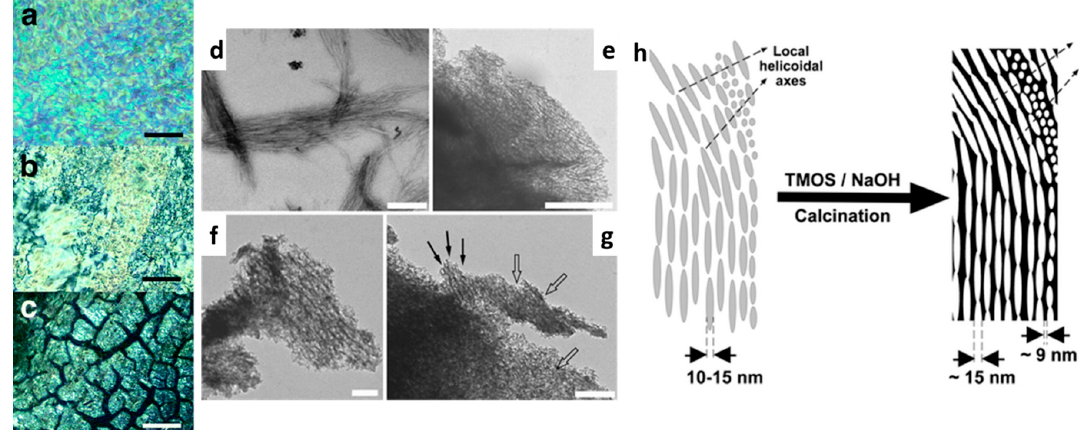
Figure 6. ( a – c ) Polarising optical microscopy images of ( a ) the cellulose nanorod nematic phase (scale bar 10 µm), ( b ) the cellulose–silica composite (scale bar 25 µm) and ( c ) the calcined silica replica (scale bar 50 µm). ( d – g ) TEM images of the unmineralised cellulose template and the silica replica. ( d ) Liquid crystalline nematic domains consisting of 10–15 nm-wide co-aligned cellulose nanorods, scale bar 200 nm; ( e ) the low-magnification image of a crushed mesoporous silica replica showing fingerprint-like patterns with cylindrical pore structure, scale bar 500 nm; ( f ) the fragment of a silica replica showing aligned 13–18 nm diameter cylindrical pores with lengths significantly extended beyond a single cellulose nanorod, scale bar 100 nm; ( g ) the high-magnification image of a silica replica showing the possible in-plane (black arrows) and out-of-plane (open arrows) projections of the pore network, scale bar 200 nm. ( h ) The schematic representation of the model for the synthesis of mesoporous silica using cellulose nanorod liquid crystal templates. Reprinted with permission from Durardin et al., J. Mater. Chem. 2003 , 13 ,